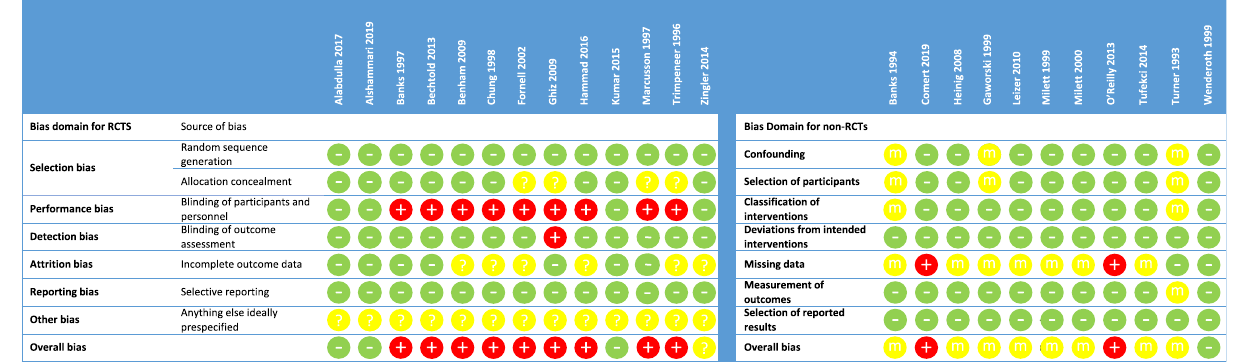
Figure 2. Risk of bias of included studies. RCTs: − , low; + , high; ?, unclear. Non-RCTs: − , low; + , high; m,